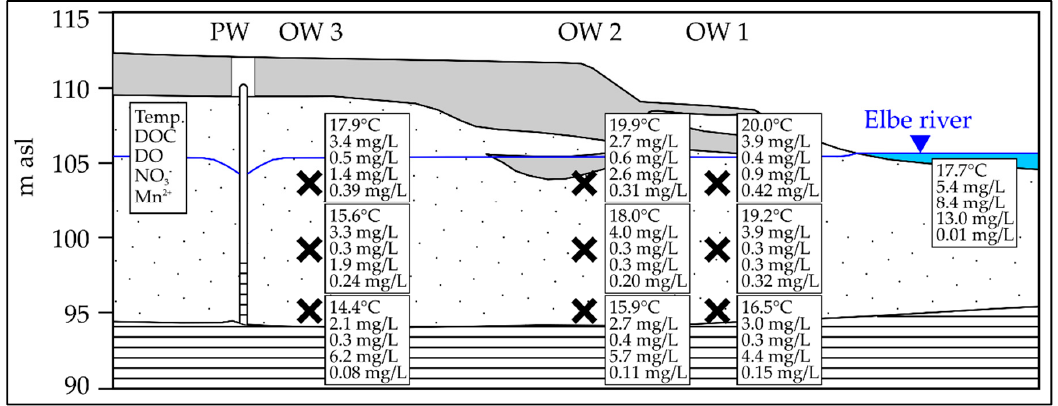
Figure 3. The mean values ( n = 2) of the relevant redox parameters along the transect in September (Table S4).